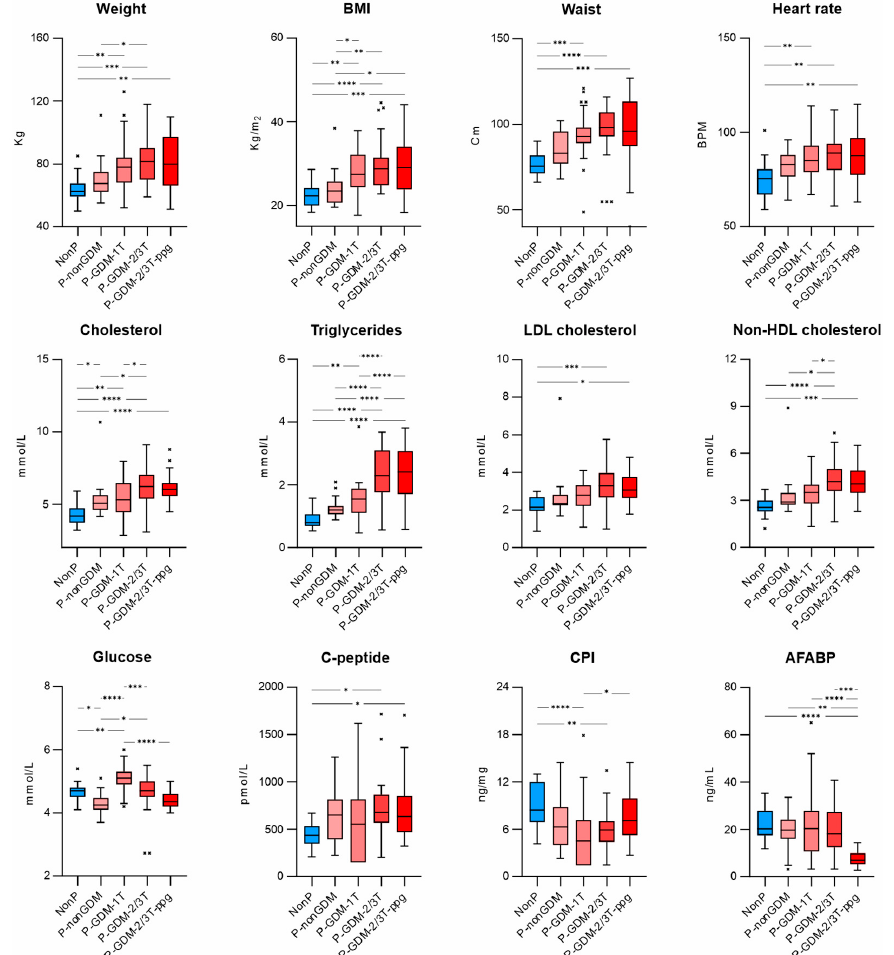
Figure 2. Distribution of baseline body composition characteristics and biochemical parameters for all groups of non-pregnant (blue) and pregnant (red) women with statistical significance (* p < 0.05, ** p < 0.01, *** p < 0.001, **** p < 0.0001). Abbreviations: AFABP, adipocyte fatty acid-binding protein.